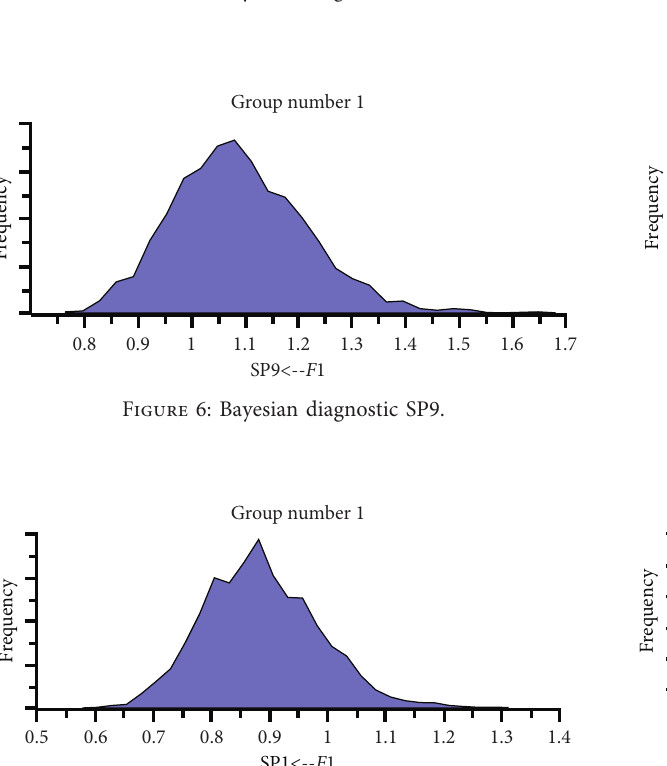
Figure 5: Bayesian diagnostic SP8.